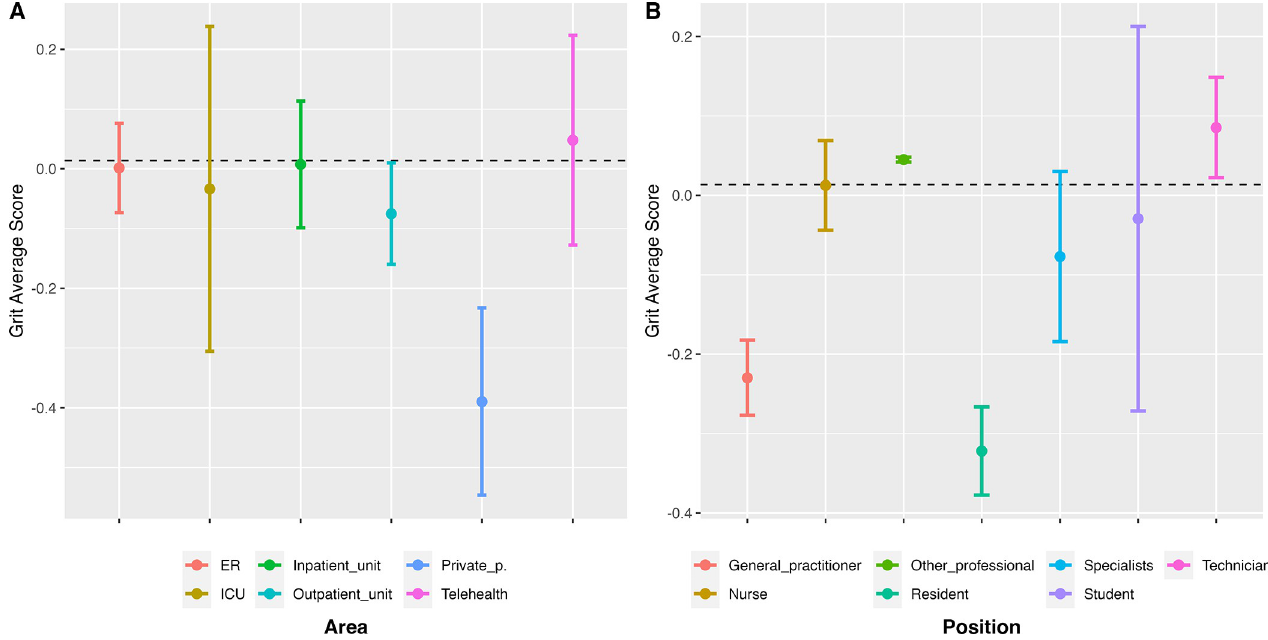
Fig 2. Grit ratings by service area and position. (A) Service area vs. grit & (B) Position vs. grit.